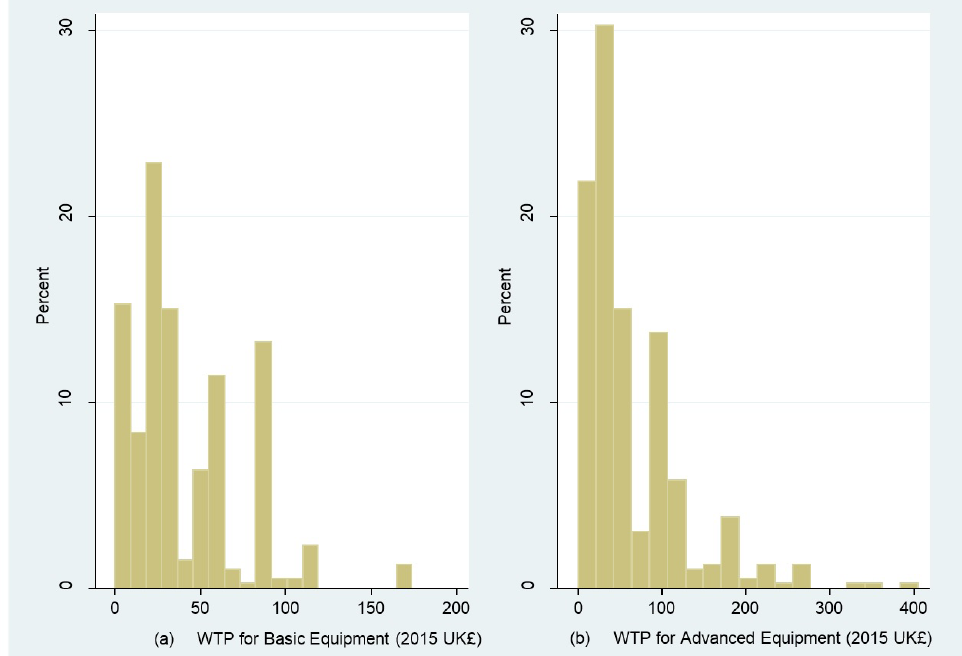
Figure 1. Distribution of Willingness to Pay (WTP) Values for Basic and Advanced Equipment